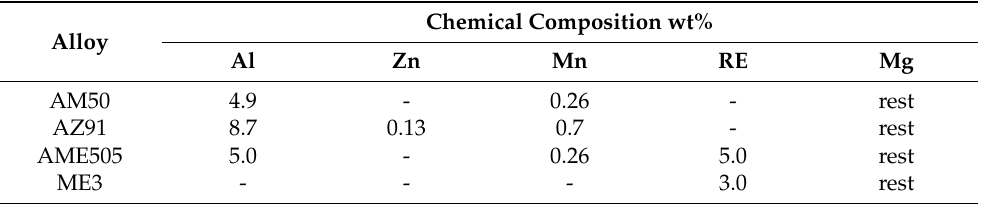
Table 1. Nominal chemical composition of used magnesium matrix alloy (where RE denotes a rare earth elements)